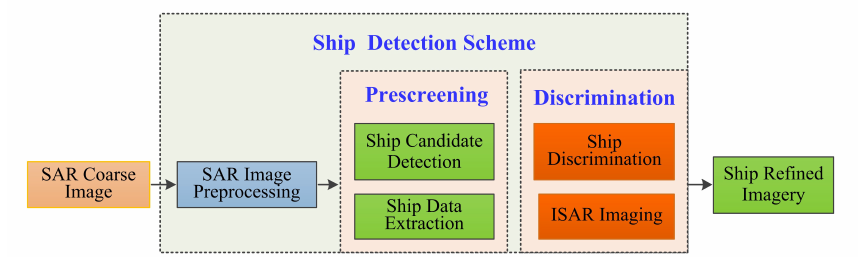
Figure 1. Illustration of ship detection and imaging